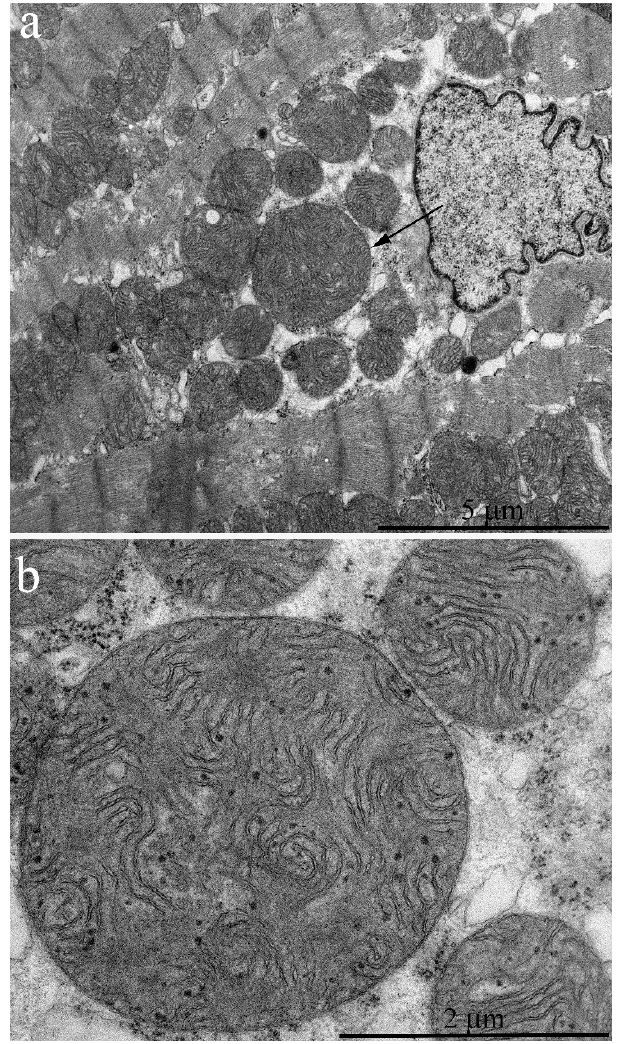
Figure 5. Electron microscopic image of the ultrastructure of a left ventricular cardiomyocyte from a 5-year-old naked mole rat: ( a ) General view at low magnification. The arrow indicates the large mitochondrion shown at higher magnification in ( b ), which shows the ultrastructural features of the large mitochondrion.